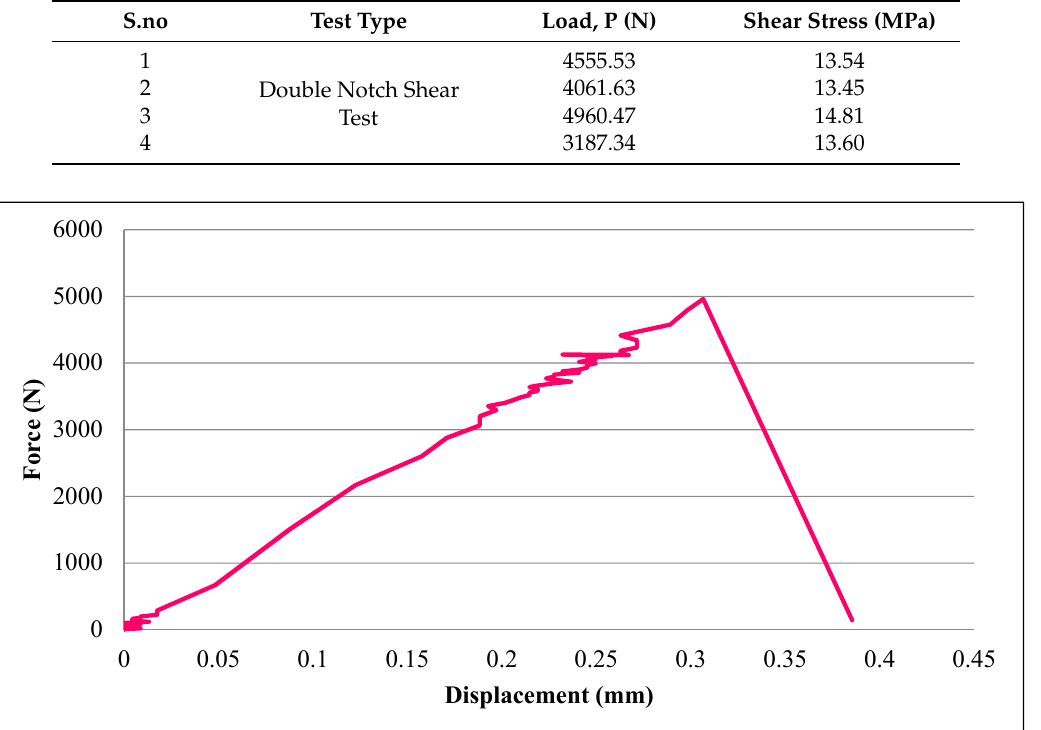
Figure 19. Typical force-displacement curve obtained from the double notch shear test.